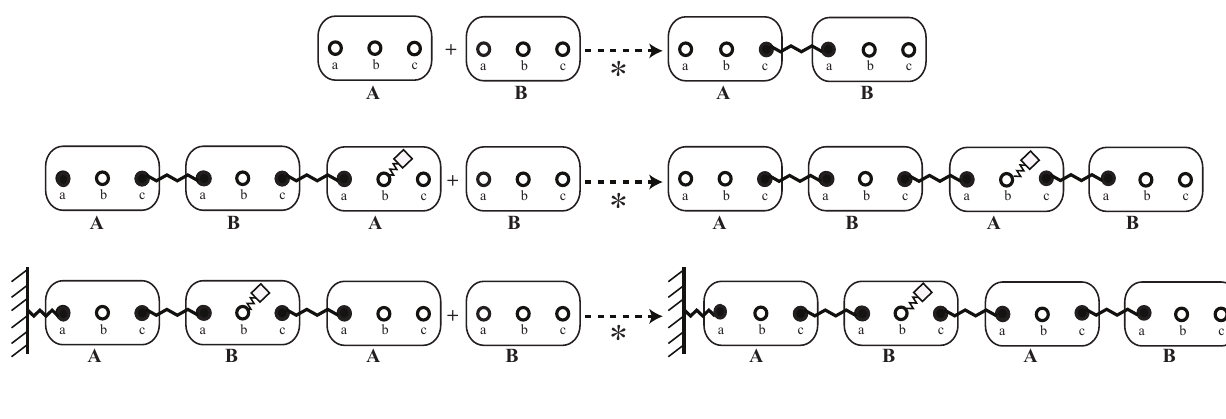
Figure 5. Instances of the reaction rule. Explicit instances of the implicit reaction rule defined in Figure 4 (upper rule), whereby, * refers to the application of the implicit rules. As described for Figure 4, the sites that were not mentioned (grey) by the rule can be modified or bound to other